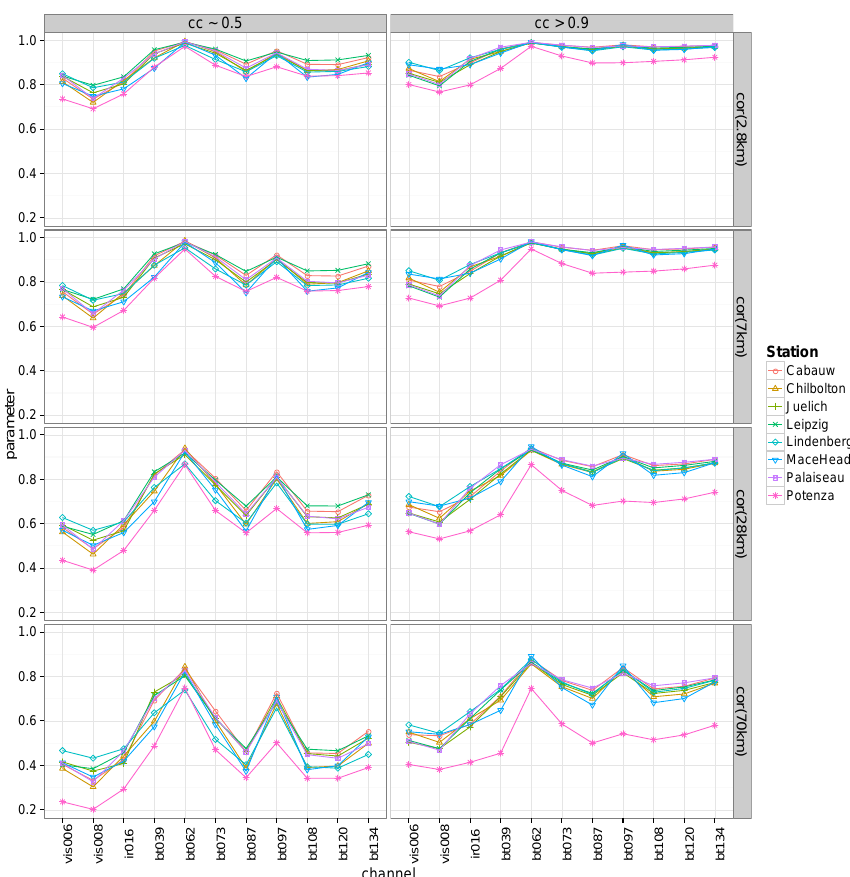
Figure 7. Comparison of correlation at distances that correspond to typical grid-sizes of forecast models (from top panel to bottom) for two cloud covers (left side: half covered scenes; right side: fully covered scenes) and for all channels ( x axis) and location (different colours, see